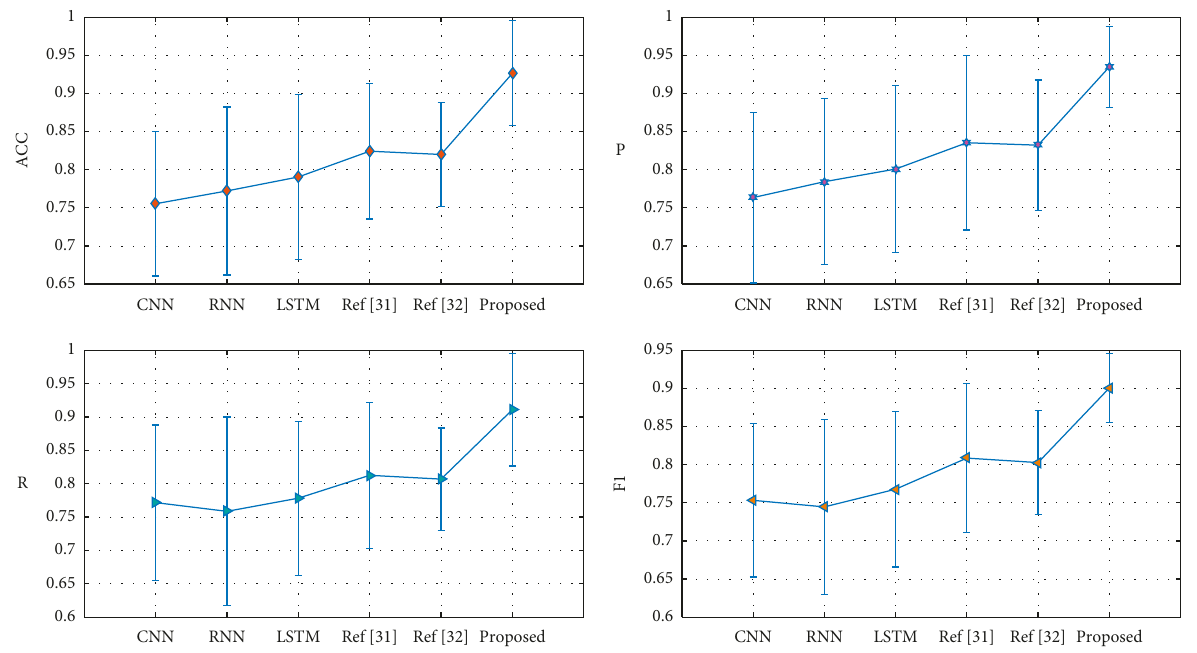
Figure 8: Experimental results of each model on different indexes in 4-classification task. Table 7: 5-classification experimental results.